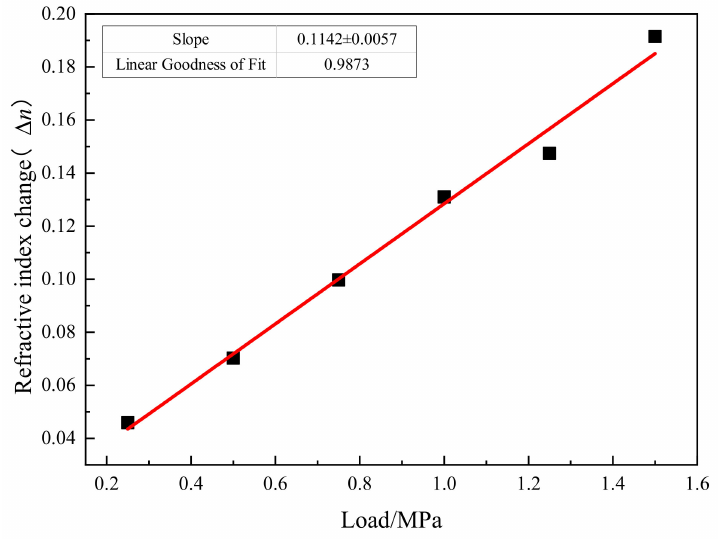
Figure 8. Under different stress states ∆ n .